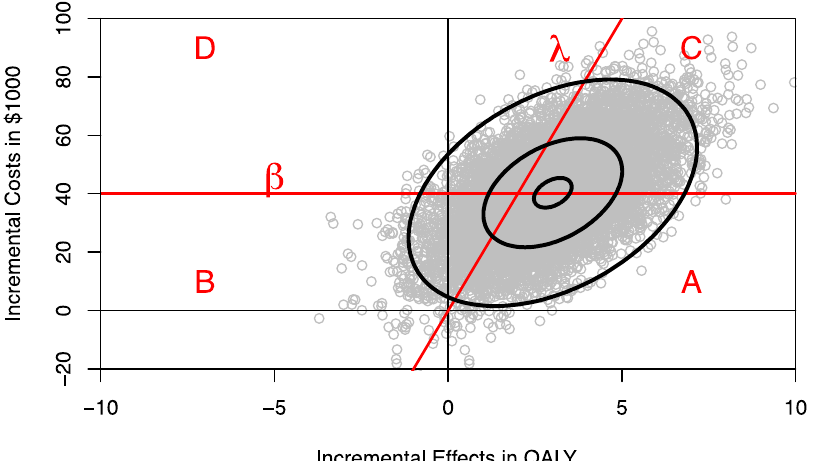
Figure 1. Incremental costs and effects of program F versus program E on the cost-effectiveness plane. λ denotes the ceiling ratio, β denotes the budget constraint. A denotes the area where the intervention is both affordable and cost-effective, B denotes the area where the intervention is affordable but not cost-effective, C denotes the area where the intervention is cost-effective but not affordable, D denotes the area where the intervention is neither affordable nor cost-effective.